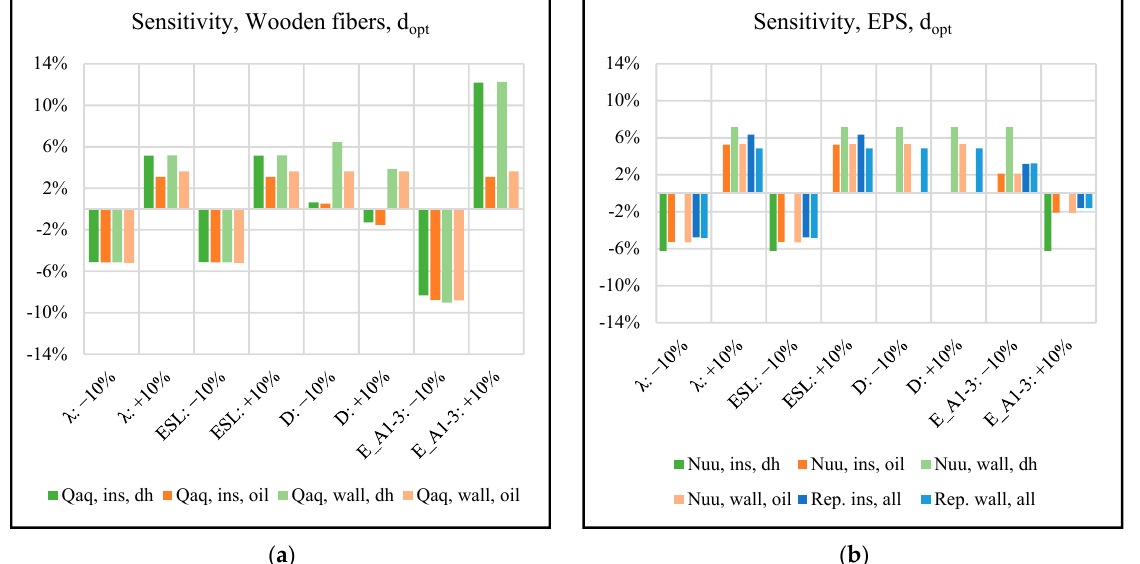
Figure 6. ( a ) is for Wooden fibers in Qaqortoq representing all cities, and ( b ) is for EPS representing all materials. Qaqortoq represents all cities except Nuuk.